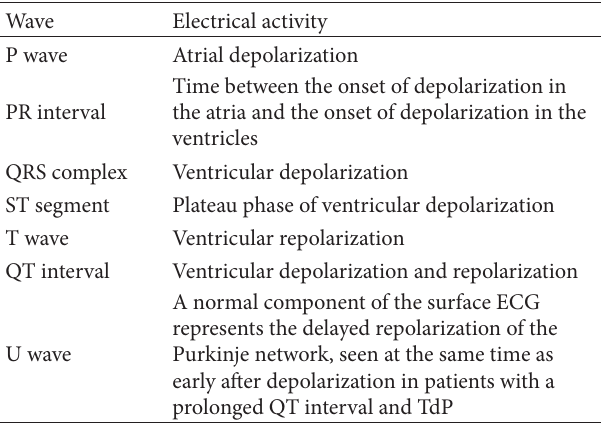
Table 3: Phases of the electrocardiogram (ECG).